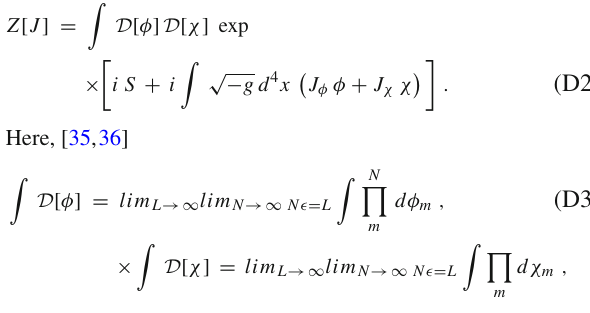
The Green function generating functional for this study before the rescaling